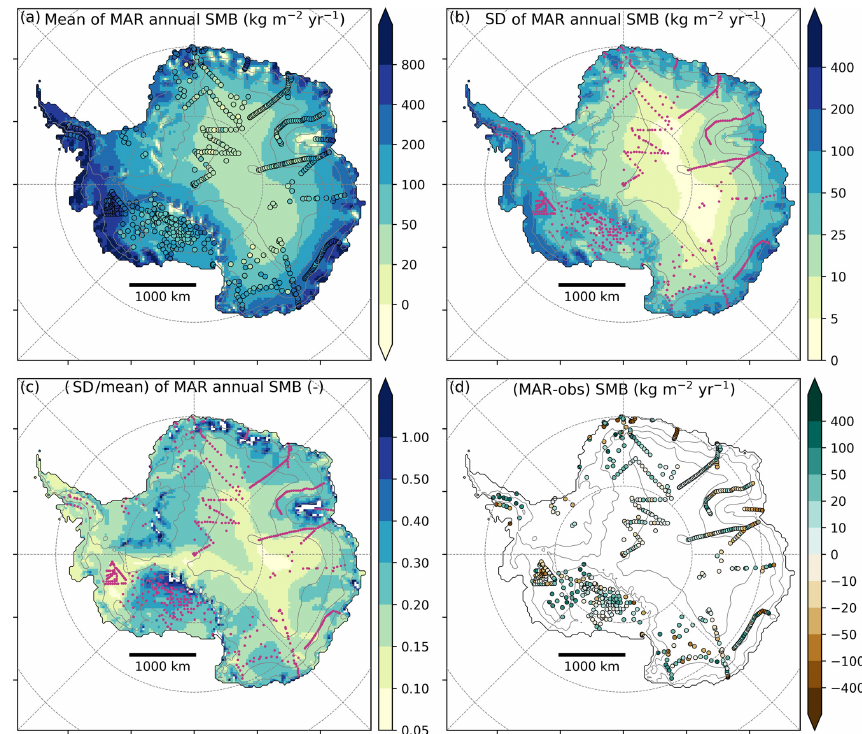
Figure 1. MAR SMB for the period 1979–2015: (a) mean annual SMB, with coloured dots showing the observed SMB values (shared colour scale); (b) standard deviation of annual SMB; (c) standard deviation divided by mean annual SMB; (d) difference between MAR and observed SMB on MAR grid cells, following the methodology detailed in Sect. 2.2.2. Magenta dots in panels (b) and (c) show the location of SMB observations. Solid grey lines are contours of surface height every 1000ma.s.l. Latitude circles are − 60, − 70, and − 80 ◦ S, and longitude lines are from 145 ◦ W to 145 ◦ E by steps of 45 ◦